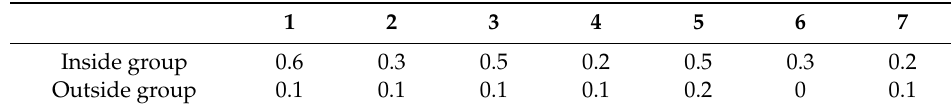
Table A1. Median of the probability for two discharge levels among the 10 biggest discharge levels to occur